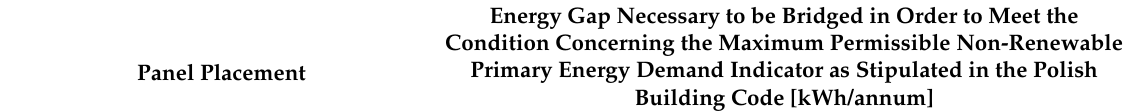
Table 7. Calculation results for energy gap to be bridged in order to meet the near-zero energy building (nZEB) requirements, hourly balance method.